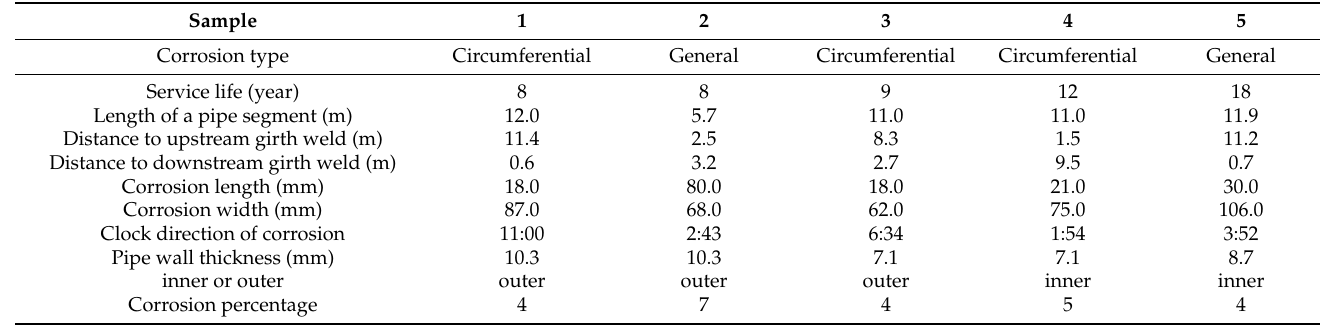
Table 2. Sample of field